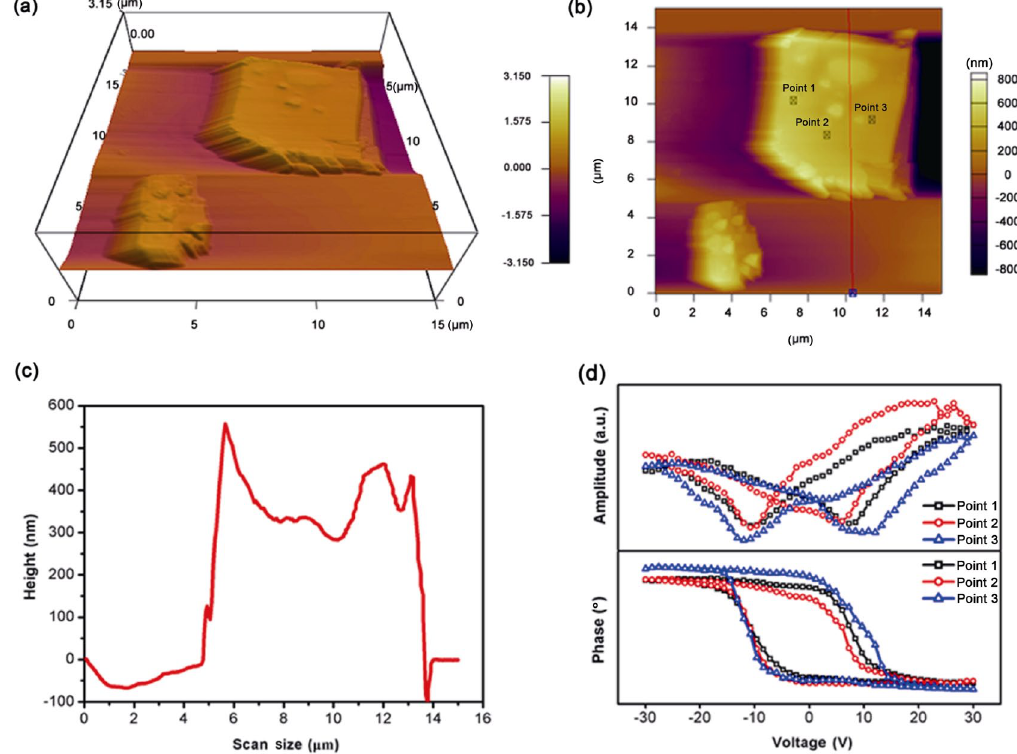
Fig. 7 (a) 3D and (b) 2D AFM images of KNN structures with the KCl/NaCl ratio of 2/1; (c) height variation of the line across the KNN structure as marked in (b); (d) piezoresponse and phase information gathered from points 1–3, as marked in